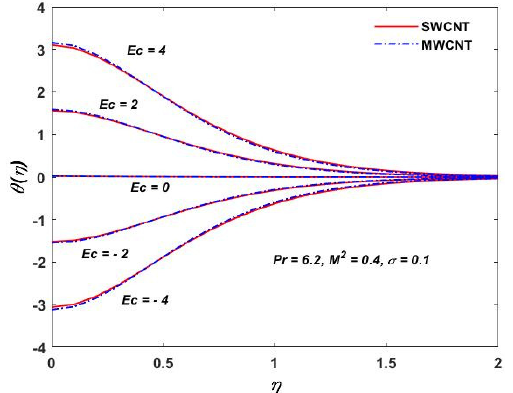
Figure 13. 𝐸𝑐𝑘𝑒𝑟𝑡 verses 𝜃(𝜂). Figure 13. Eckert verses θ ( η )